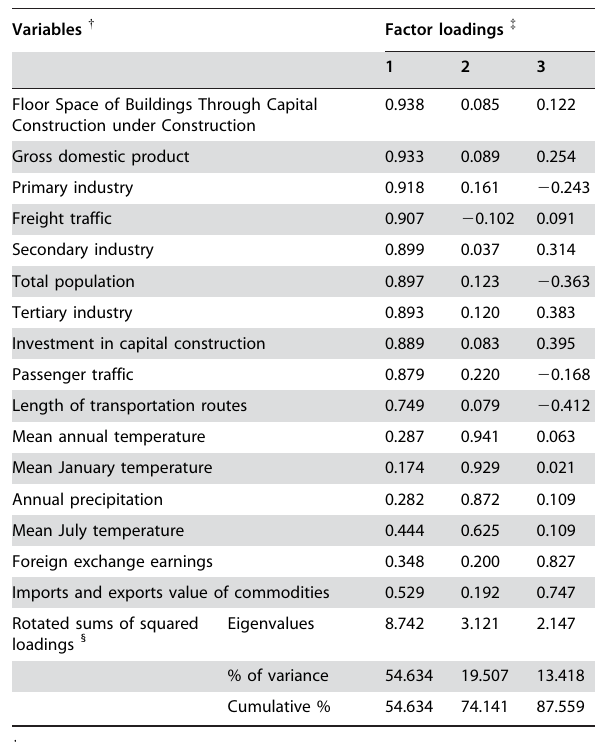
Table 1. Result of the principal factor analysis of economic